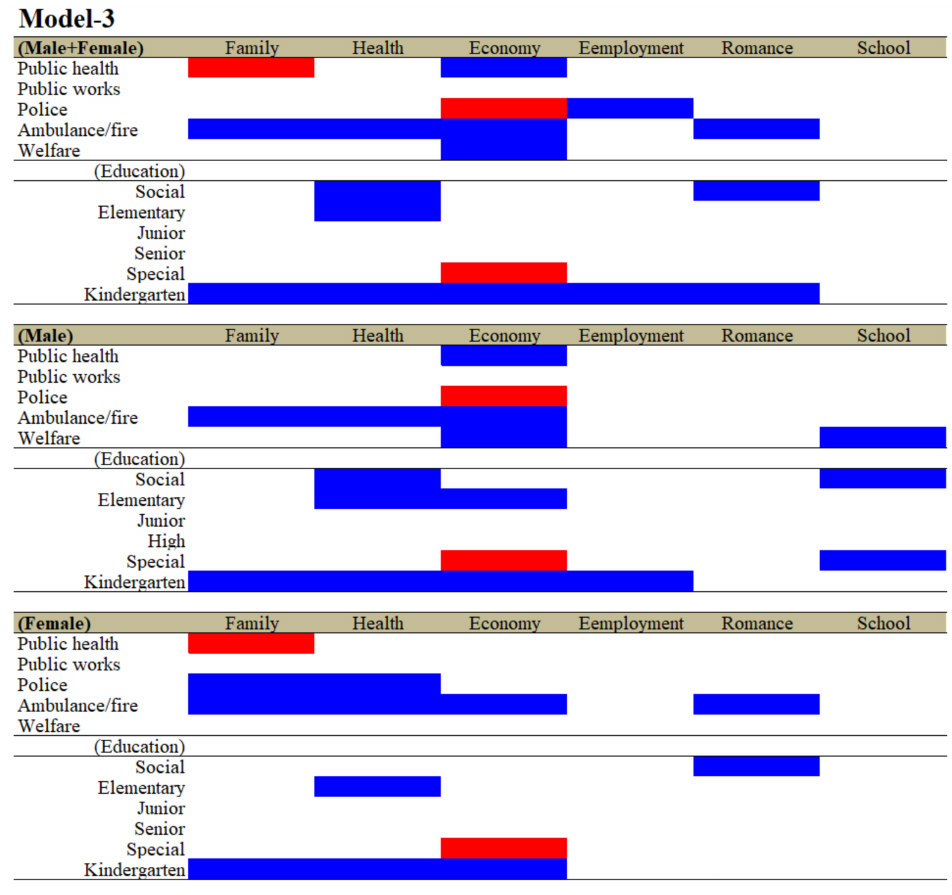
Figure 3. Relationship between financial expenditure per capita of divisions and subdivision of education of prefectures/municipalities, and suicide mortalities caused by six major motives for both genders (males + females), males and females from 2009 to 2018 using fixed- or random-effect analyses of hierarchal linear regression with robust standard error. Blue and red columns denote significant factors for decreasing and increasing suicide mortalities, respectively. The detailed statistical values are presented in Supplementary Tables